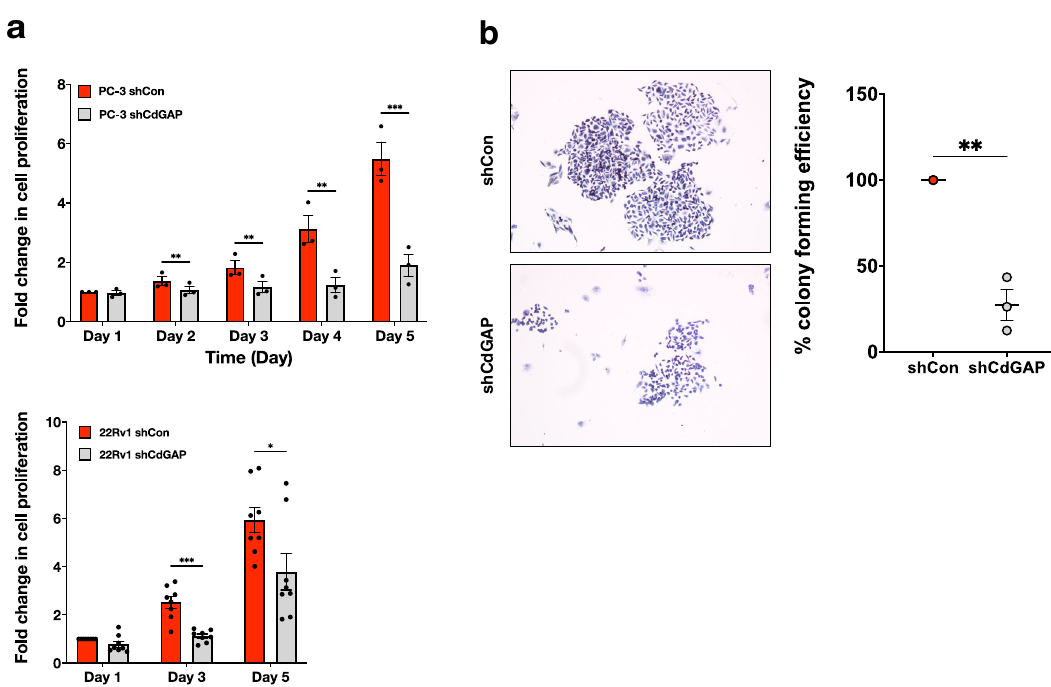
Fig. 4 CdGAP promotes cell proliferation in CRPC cells. a MTT assays from control (shCon) or CdGAP-depleted (shCdGAP) PC-3 and 22Rv1 cells over a period of 5 days (PC-3: n = 3; 22Rv1: n = 8). b Representative images of an in vitro colony formation assay. Scale bar represents 100 μ m. Colony-forming ef fi ciency is plotted relative to control PC-3 cells ( n = 3). Two-sample unpaired Student ’ s t test for comparison between two groups (shCon; shCdGAP). Error bars indicate SEM. *** p < 0.001; ** p < 0.01; * p <